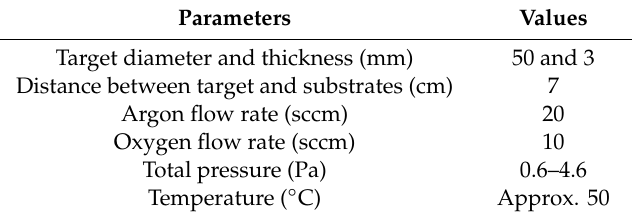
Table 1. Experimental conditions for the elaboration of the La-Cu-O